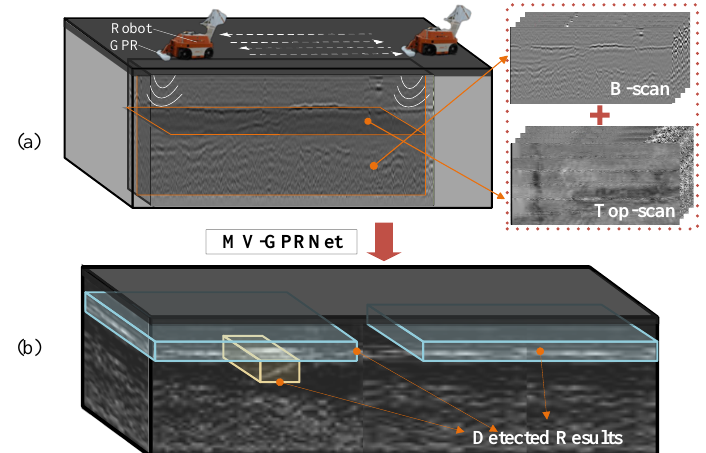
Figure 1. An illustration of our subsurface defect detection problem: ( a ) Our inspection robot equipped with a multi-channel GPR, and generates a set of B-scans and Top-scans GPR data; ( b ) Detected 3D bounding boxes of subsurface defects. The different color of the box indicates different